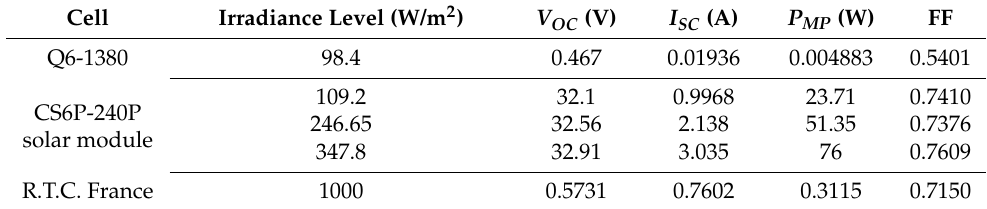
Table 1. Basic open circuit and short circuit current for tested solar